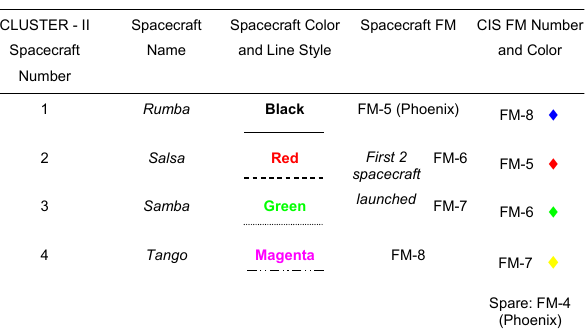
Table 1. CIS Flight Model (FM) Naming